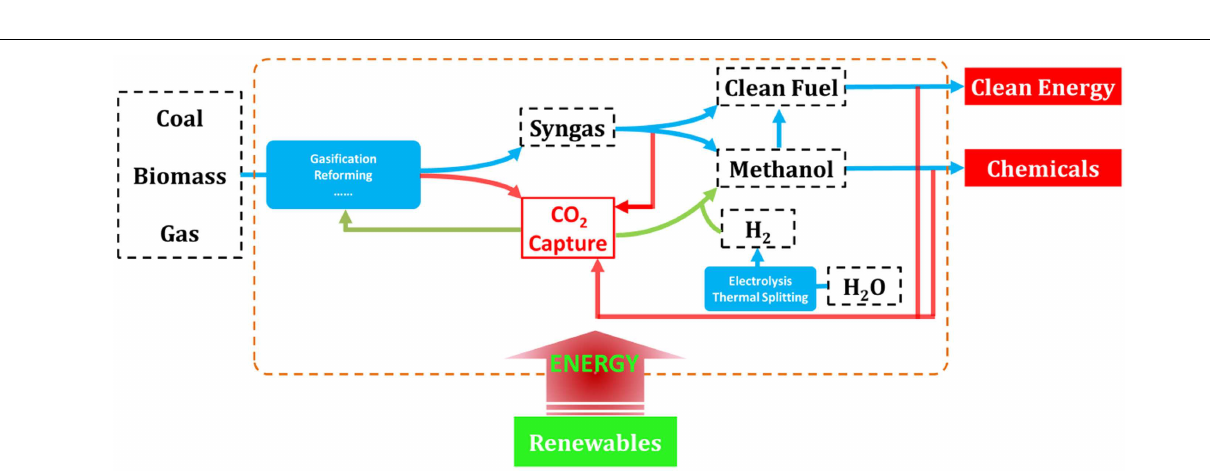
FIGURE 1 | Overall solutions for low-carbon energy and chemical production from fossil, biomass, and renewable sources .